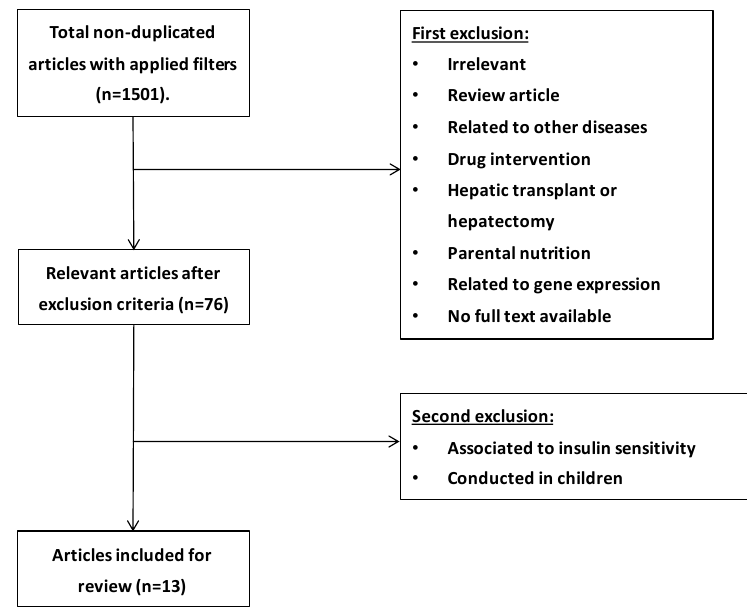
Figure 3. Flowchart of selection process based on n-3 PUFA and NAFLD/NASH.